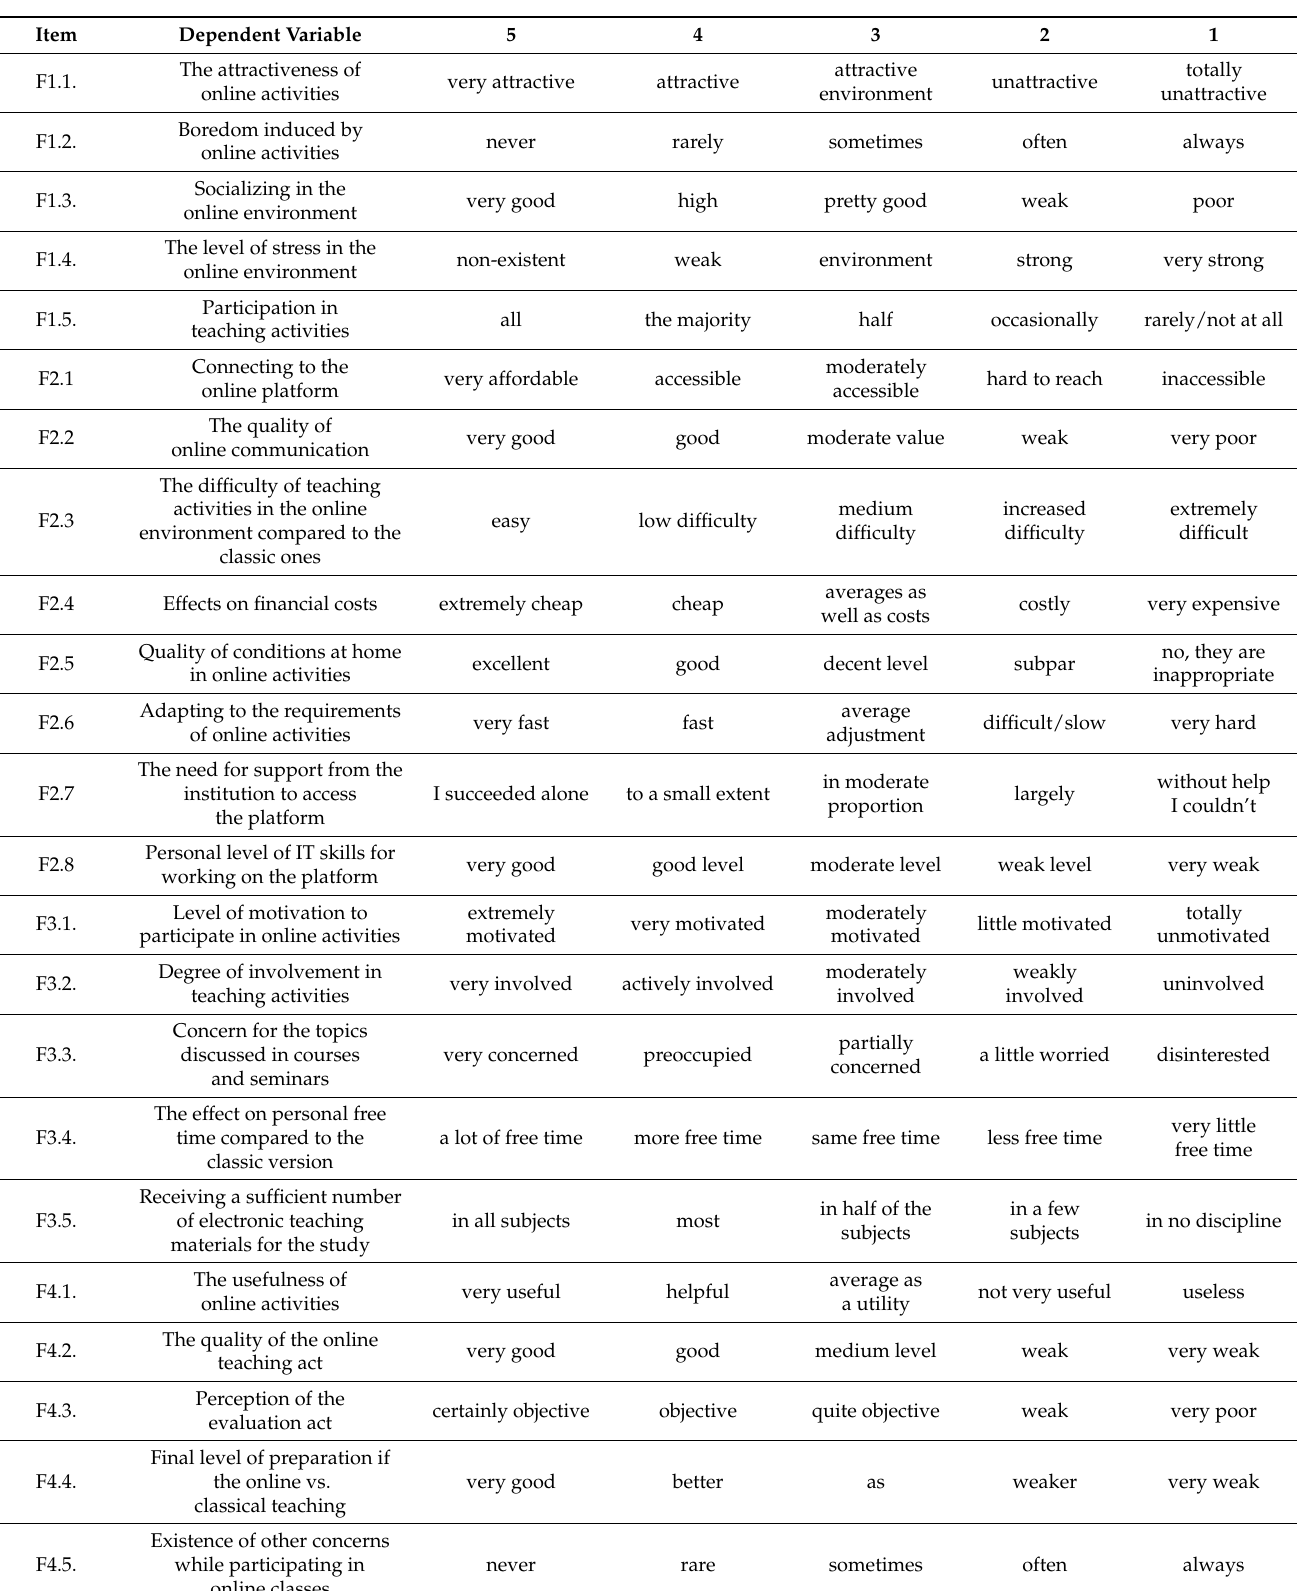
Table 1. Likert scale for questionnaire